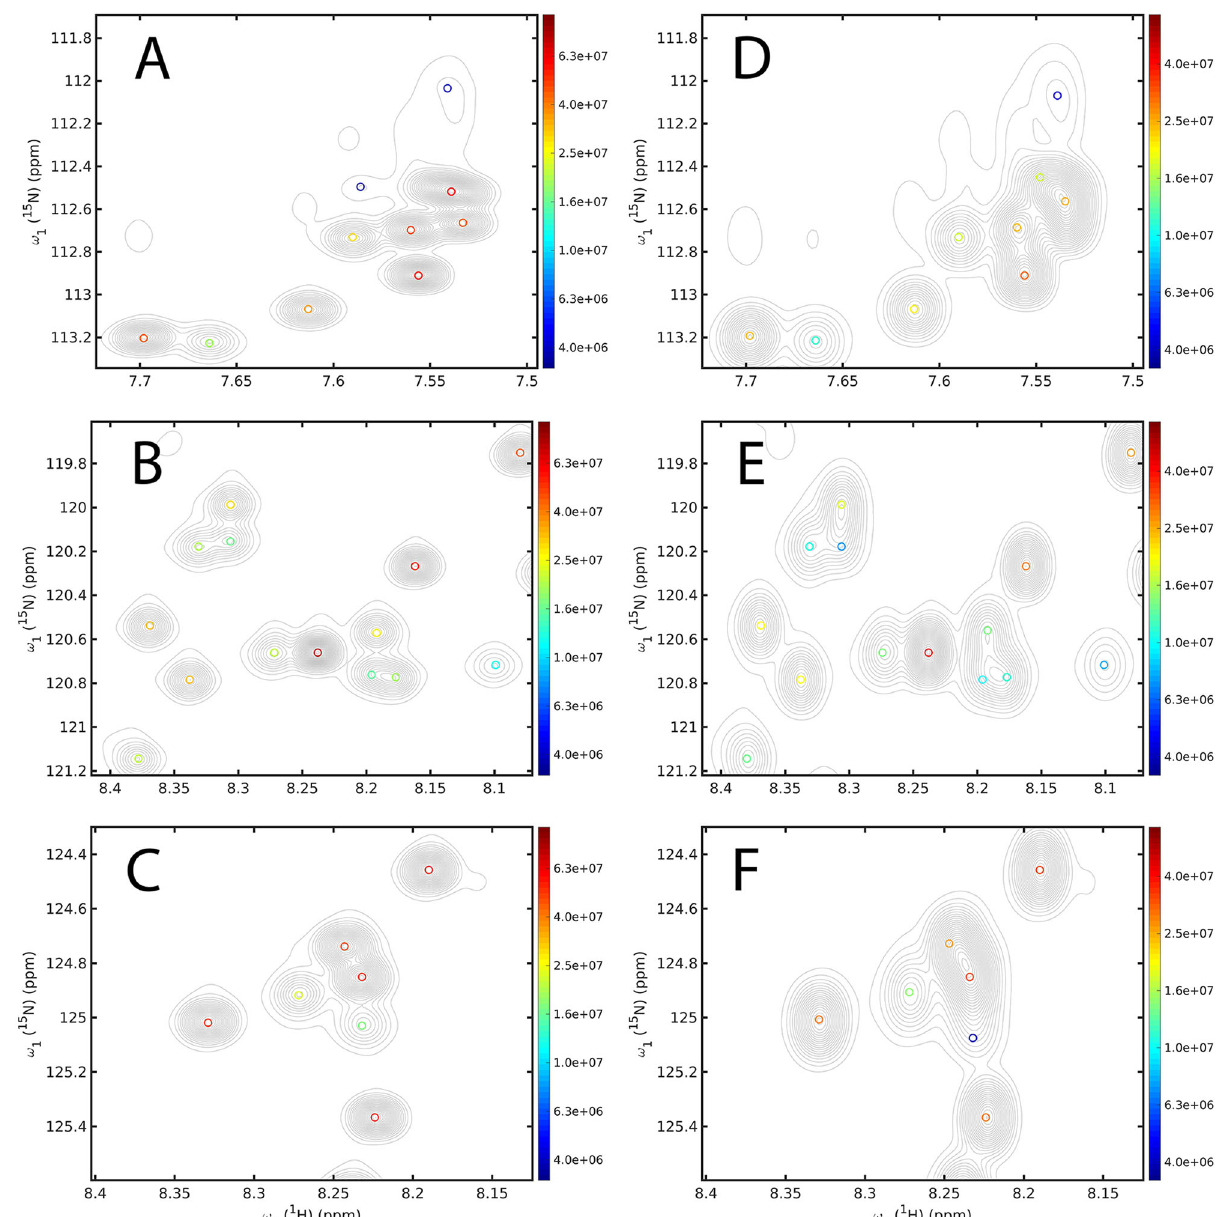
Fig. 5 Performance of DEEP Picker for selected regions of 2D 15 N – 1 H HSQC spectrum of α -synuclein. A – C HSQC spectrum processed with original resolution and D – F with reduced resolution along indirect dimension. Three pairs of panels ( A , D ), ( B , E ), ( C , F ) show the same 2D regions for comparison. Picked cross-peaks are indicated as circles and color-coded according to their amplitude on a logarithmic scale, whereas the contour line spacings are linear. Despite the lower spectral resolution in D – F , DEEP correctly picked the peaks, including all strongly overlapped cross-peaks. Note that the spectra of Panels D – F have reduced sensitivity since they used only half of the time-domain